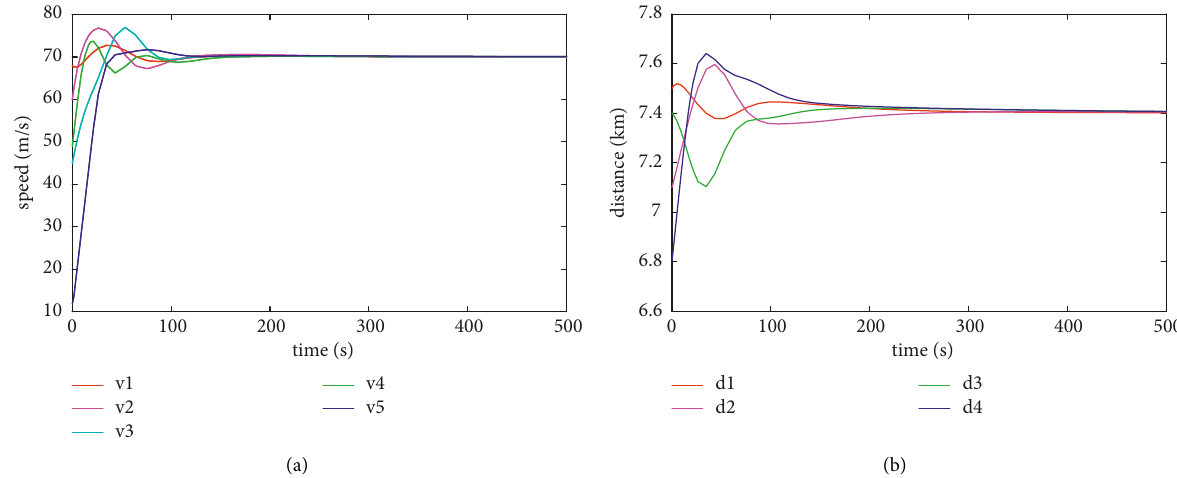
Figure 3: The simulation results of applying the proposed cooperative tracking control strategy, in which the potential function parameter a � 1. (a) The speed curves. (b) The distance between adjacent trains, in which d th train, respectively.